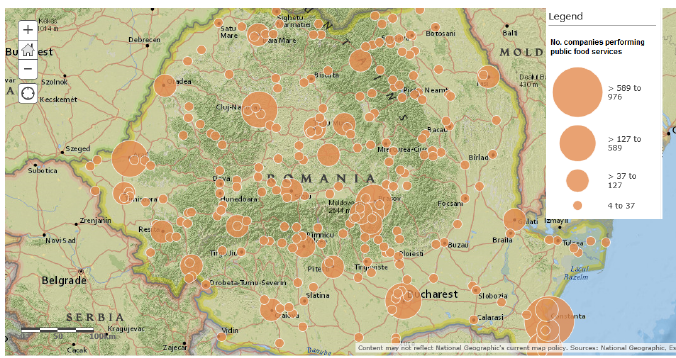
Figure 2: Spatial distribution of foodservice companies